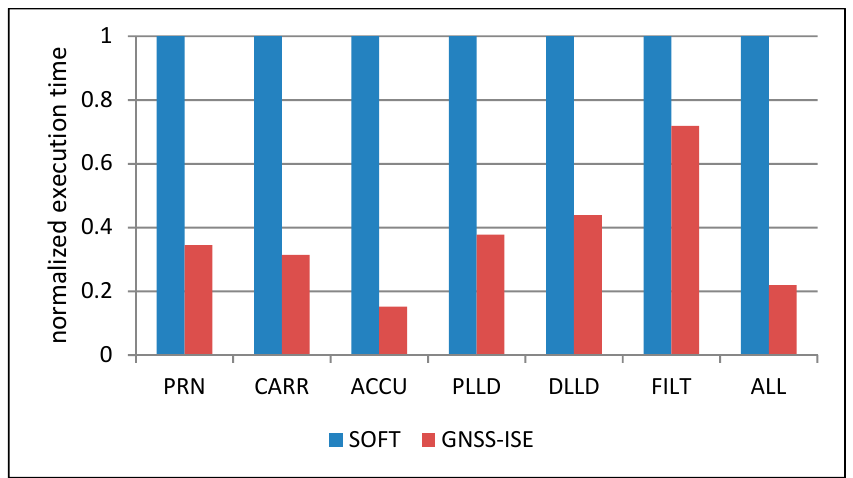
Figure 10. Normalized standard cells’ area as a function of GNSS tracking channels.